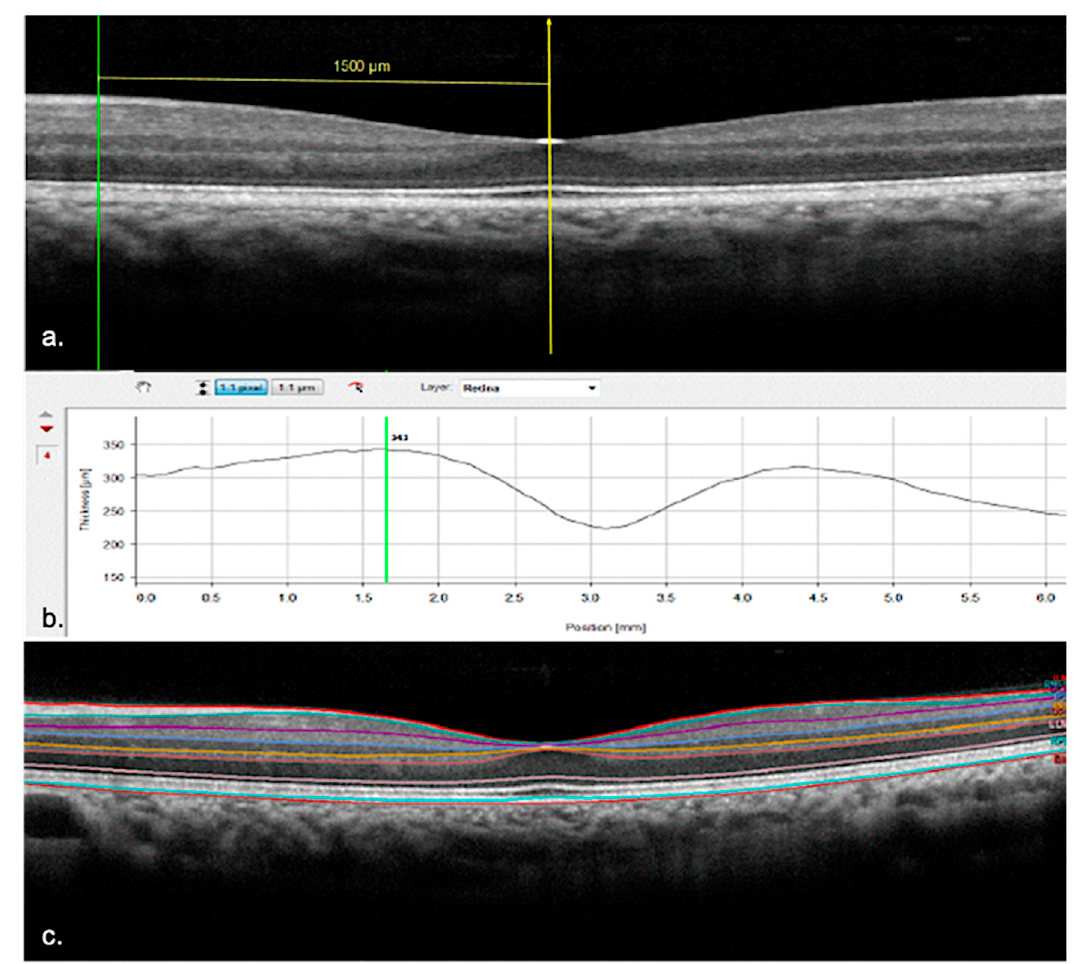
Figure 1. ( a ) Positioning of the caliper measuring 1500 microns nasally from the fovea. ( b ) Thickness measurement performed by Heyex Segmentation Software. ( c ) Segmentation of the individual retinal layers with colored lines imposed on the interfaces.